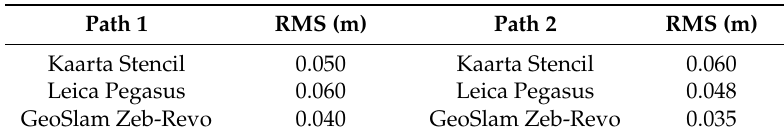
Table 1. RMS of signed distances after iterative closest point (ICP) alignments of the indoor mobile mapping system (IMMS)